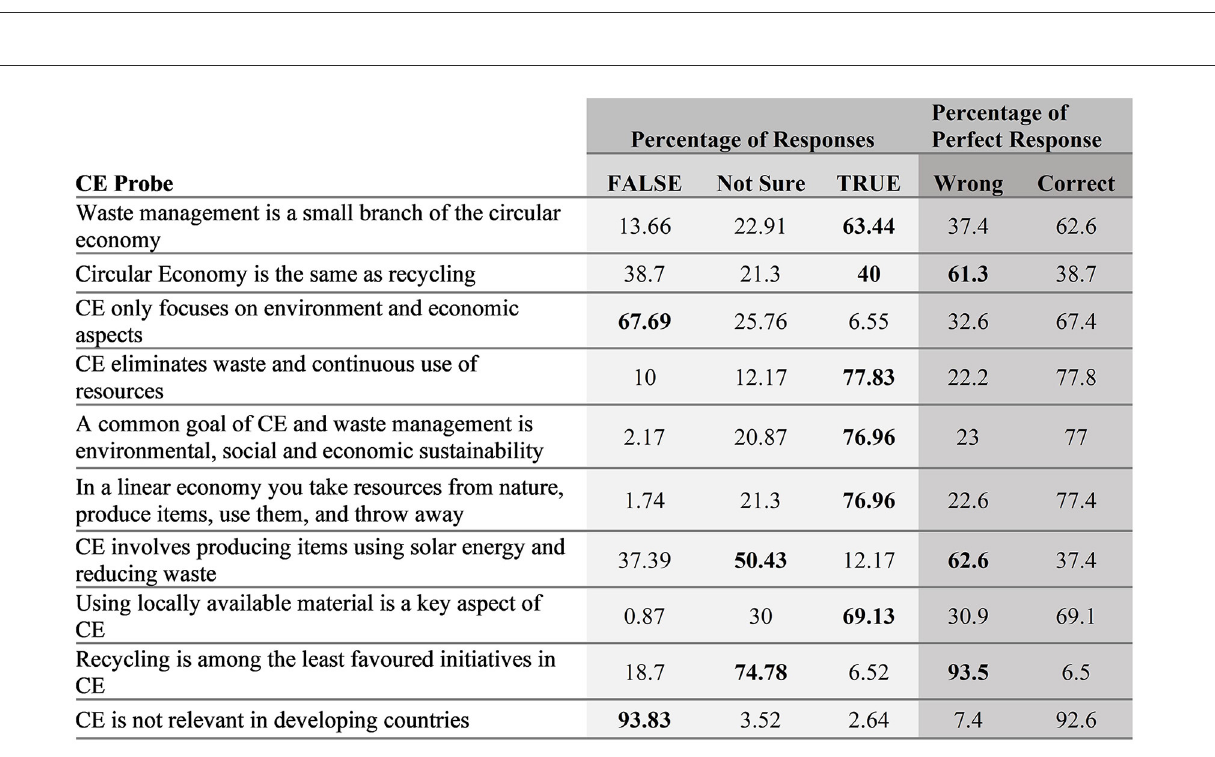
FIGURE4 Rank of CE benefits by respondents.